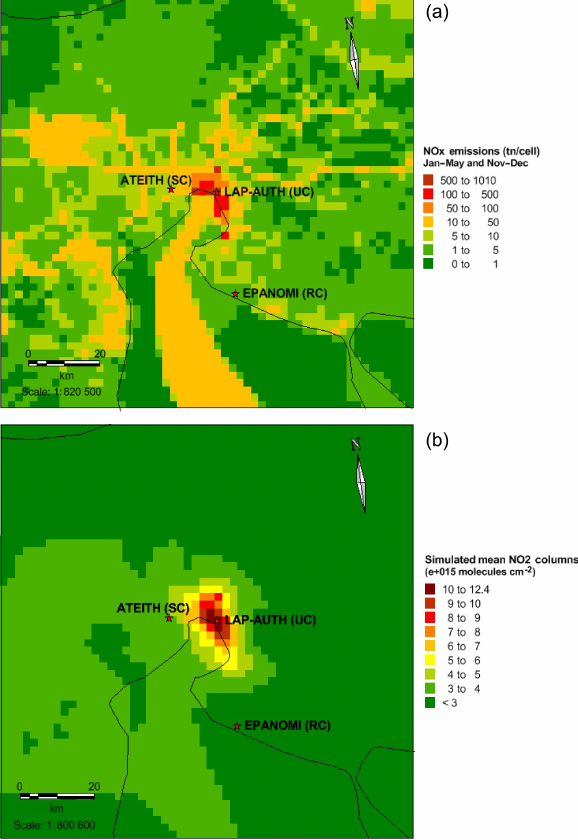
Figure 6. Panel (a) shows the total NO x emissions of the period November to May for the domain of Thessaloniki; (b) shows the simulated NO 2 VCD averaged over the period of the campaign for the same